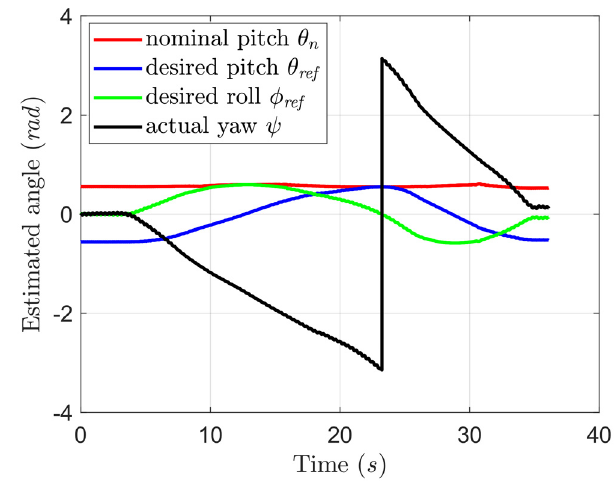
Figure 11. Omnidirectional walking on a 35° slope.